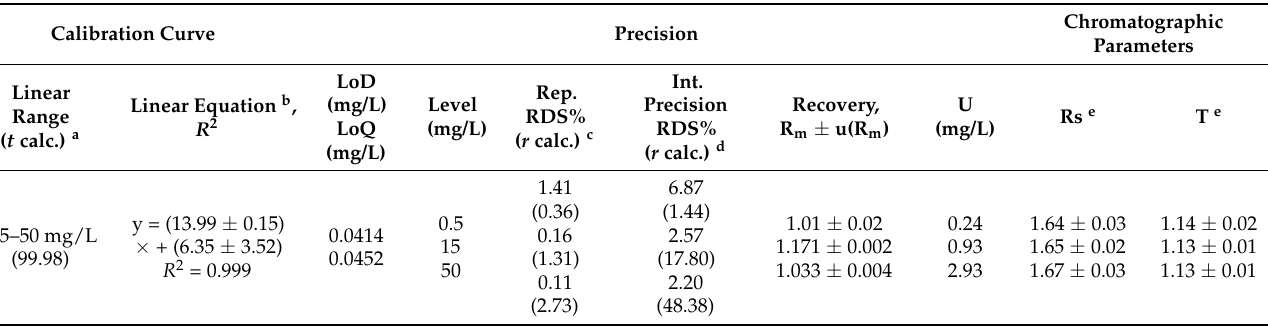
Table 1. Calibration curves, limit of detection and limit of quantification, precision, recovery, uncer- tainties, resolution, and tailing factor for LD determination by using LC-UV method. Calibration Curve Precision